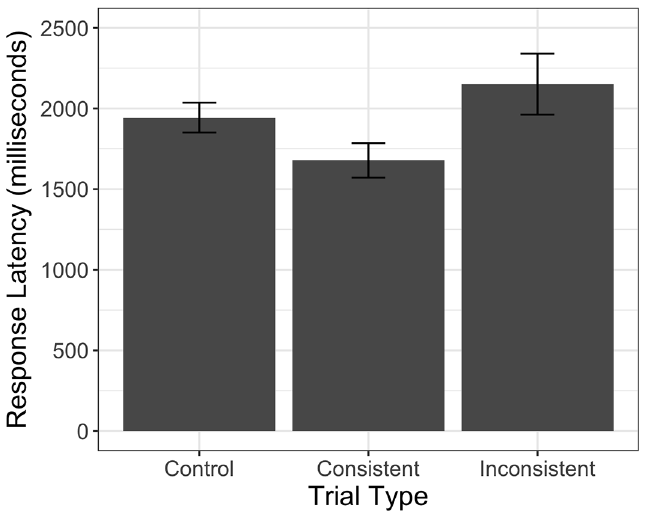
Figure 2. Effect of trial type on response latency in Experiment